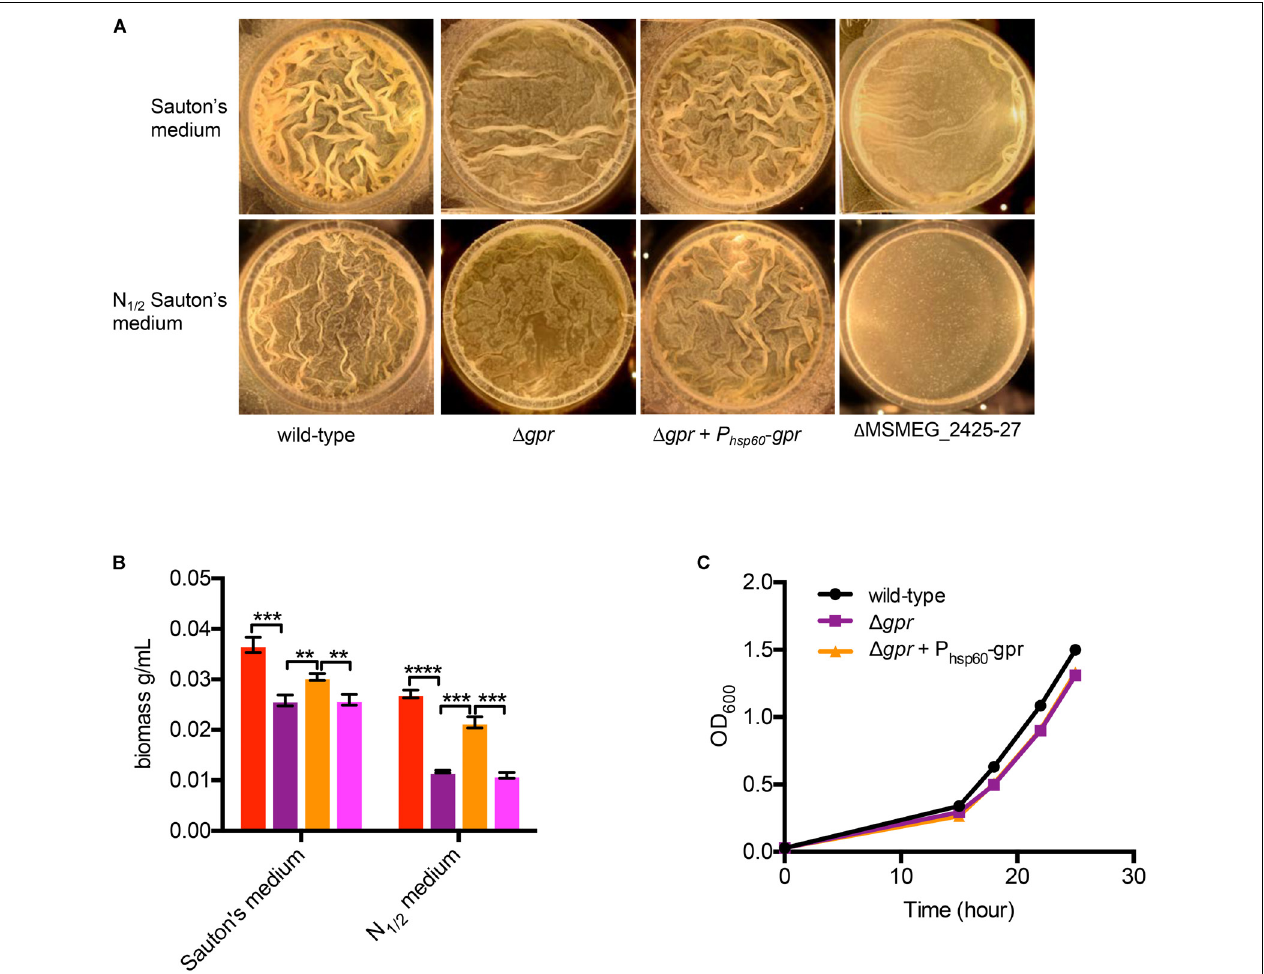
FIGURE 6 | Role of gpr in biofilm formation of M. smegmatis. (A) A top-down view of pellicle biofilms of the indicated strains after days of growth in detergent-free Sauton’s medium and modified Sauton’s medium with half the normal nitrogen source (N 1 / 2 ). In contrast to the wild type, which formed thick-textured biofilms in both medium, (cid:49) amt 1 and (cid:49) gpr mutants formed untextured biofilms in N 1 / 2 Sauton’s medium, and the phenotype was partially rescued by nitrogen restoration in normal Sauton’s medium. (B) Biomass of the pellicles described in (A) from three independent experiments. The order of columns in the plot corresponds to the order in which the strains are indicated in (A) . Data represent mean of three biologically independent experiments. ∗∗ , ∗∗∗ , and ∗∗∗∗ denote p < 0.01, 0.001, and 0.0001, respectively ( t -test). (C) Planktonic growth of the indicated strains in N 1 / 2 Sauton’s medium.